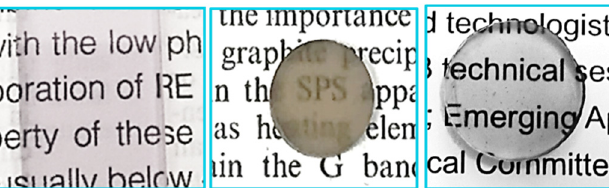
Figure 5. Rare earth-doped transparent oxyfluoride GCs prepared by (from left to right) melt quenching, SPS with uncovered graphite die, SPS with platinum foil.